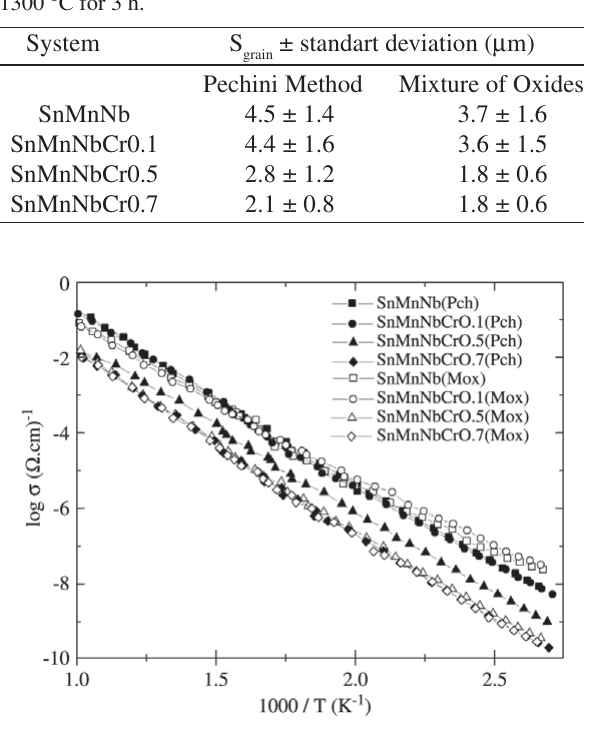
Figure 4. Electrical conductivity as a function of temperature of system SnMnNbCrx, with 0 ≤ x ≤ 0.7% mol, sintered at 1300 °C for 3